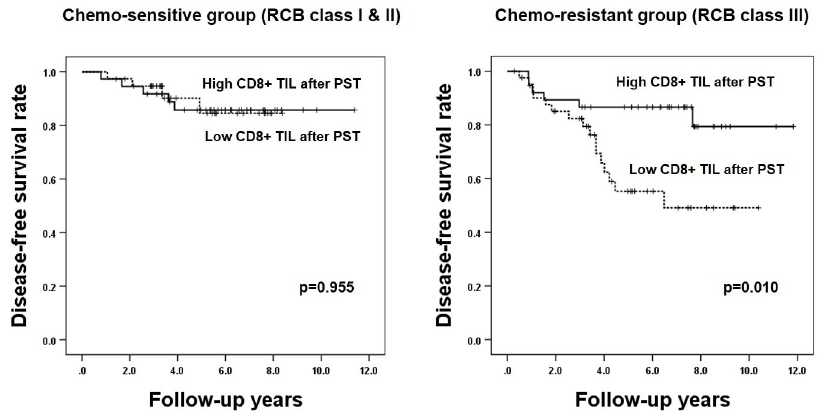
Fig 3. Kaplan-Meier survival analyses based on level of CD8+ tumor-infiltrating lymphocyte infiltration after primary systemic therapy according to chemo-responsiveness. High level of the CD8+ tumor-infiltrating lymphocyte (TIL) infiltration after primary systemic therapy (PST) is associated with longer patient disease-free survival in chemo-resistant group (RCB class III), but not in the chemo-sensitive group (RCB class I & II).